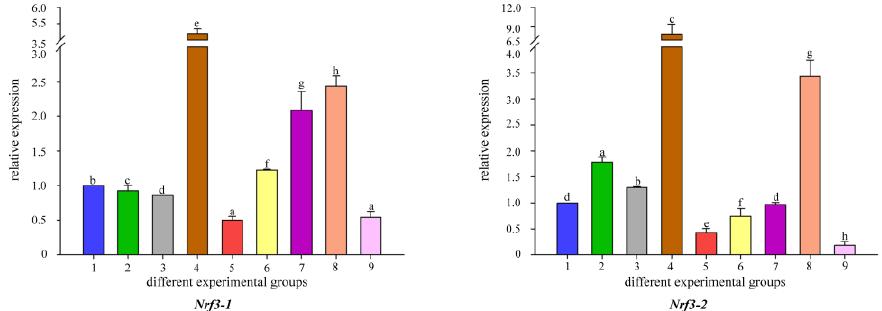
Figure 6. Temporal expression of Nrf 2 mRNA relative to control and normalized by qRT-PCR for changes in β -actin in the gut of common carp, challenged for 30 and 60 days. Significant differences between the challenge, infection, and control groups are indicated by letters, p < 0.05: 1 is the blank control group; 2 is the heavy metal Cd 2+ -stress group at 30 days; 35 is the B. coagulans group with L1, L2, and L3 concentrations in the feed at 30 days; 6 is the heavy metal Cd 2+ -stress group at 60 days; 79 is the B. coagulans group with L1, L2, and L3 concentrations in the feed at 60 days group.